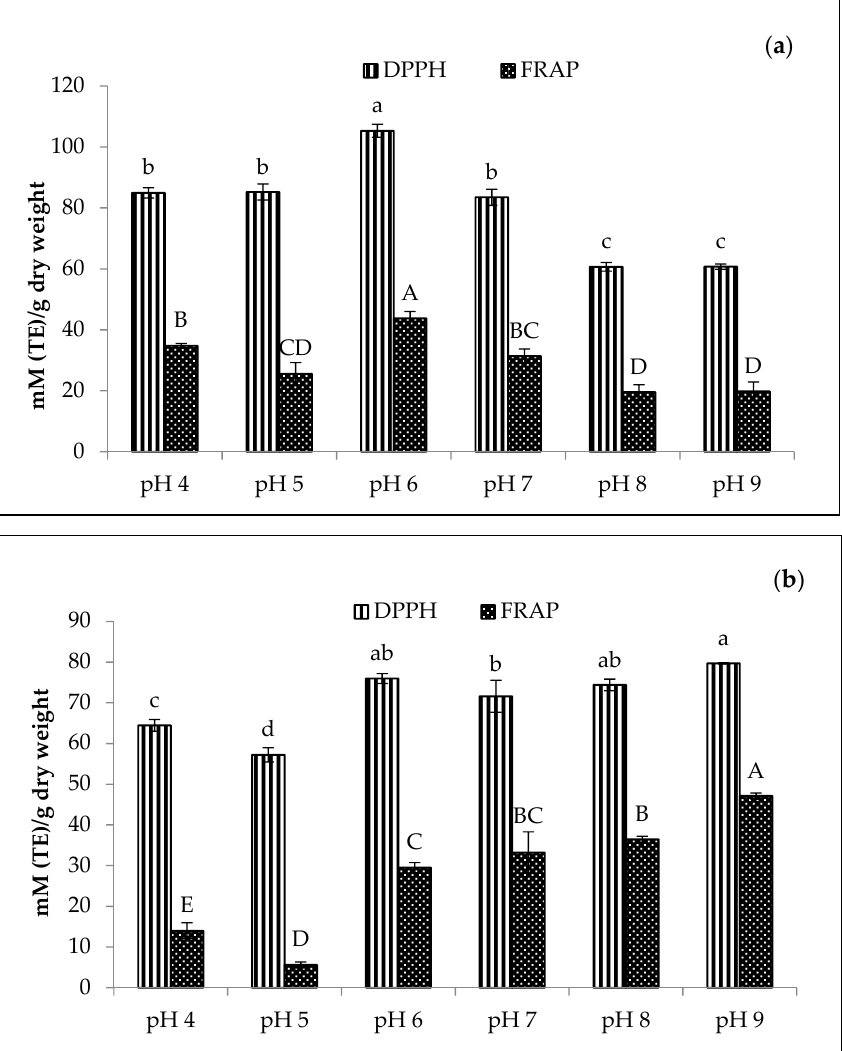
Figure 7. Effect of pH on antioxidant activities of ( a ) 210 mg/L of CuSO 4 and ( b ) 1500 mg/L of ZnCl 2 stabilised amaranth purees after heating at 80 °C for 15 min. Each value was expressed as mean ± standard deviation ( n = 3) of triplicate analysis. The bars with different lowercase (a–d) and uppercase (A–E) letters indicate significant differences ( p < 0.05) in Tukey’s HSD test.